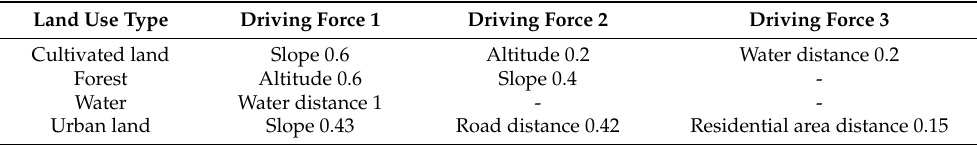
Table 4. Weight of driving forces for each land use type in the CA-Markov model establishment. Land Use Type Driving Force 1 Driving Force 2 Cultivated land Slope 0.6 Water Urban land Slope 0.43